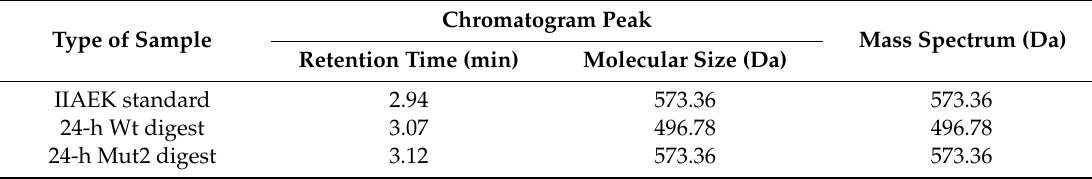
Table 6. Liquid chromatography-mass spectrometry (LC-MS) data of the 24-h Wt and Mut2 digests. Type of Sample